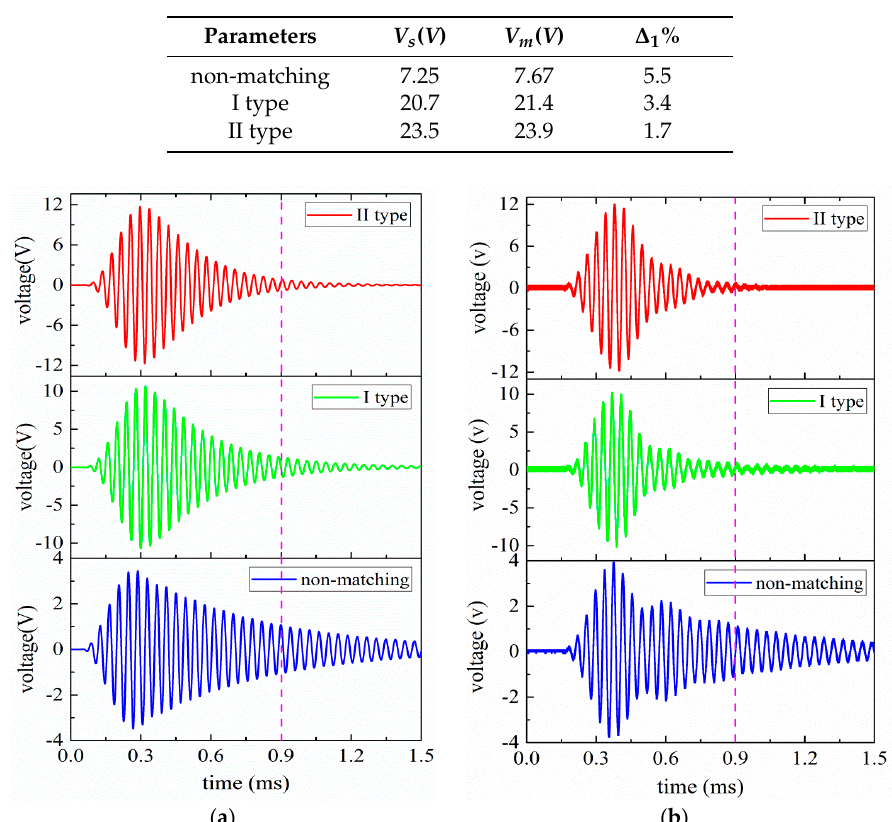
Figure 13. The transient analysis results of the pitch-catch setup with EIM network, ( a ) the simulated results, ( b ) the measured results.